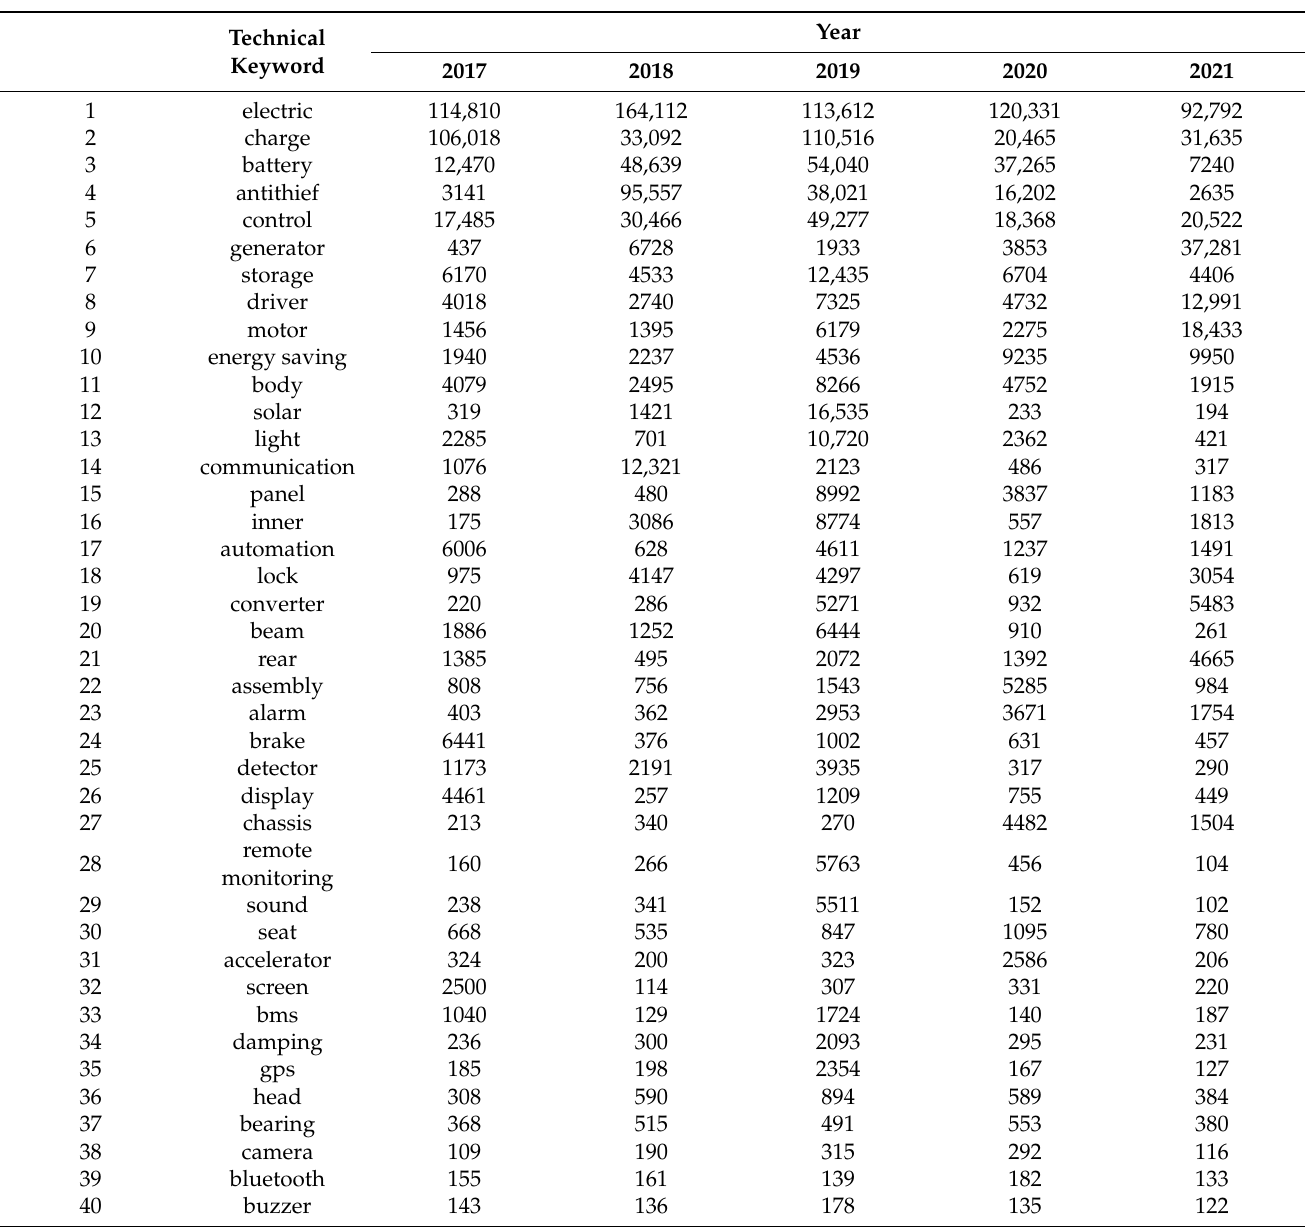
Table 2. Technical keywords in the field of EVs in